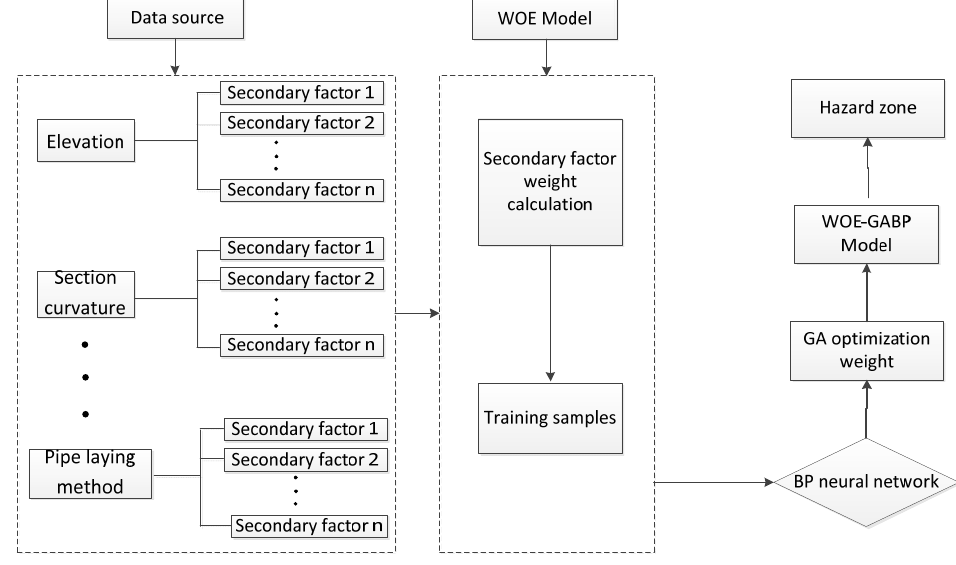
Figure 2. Technology